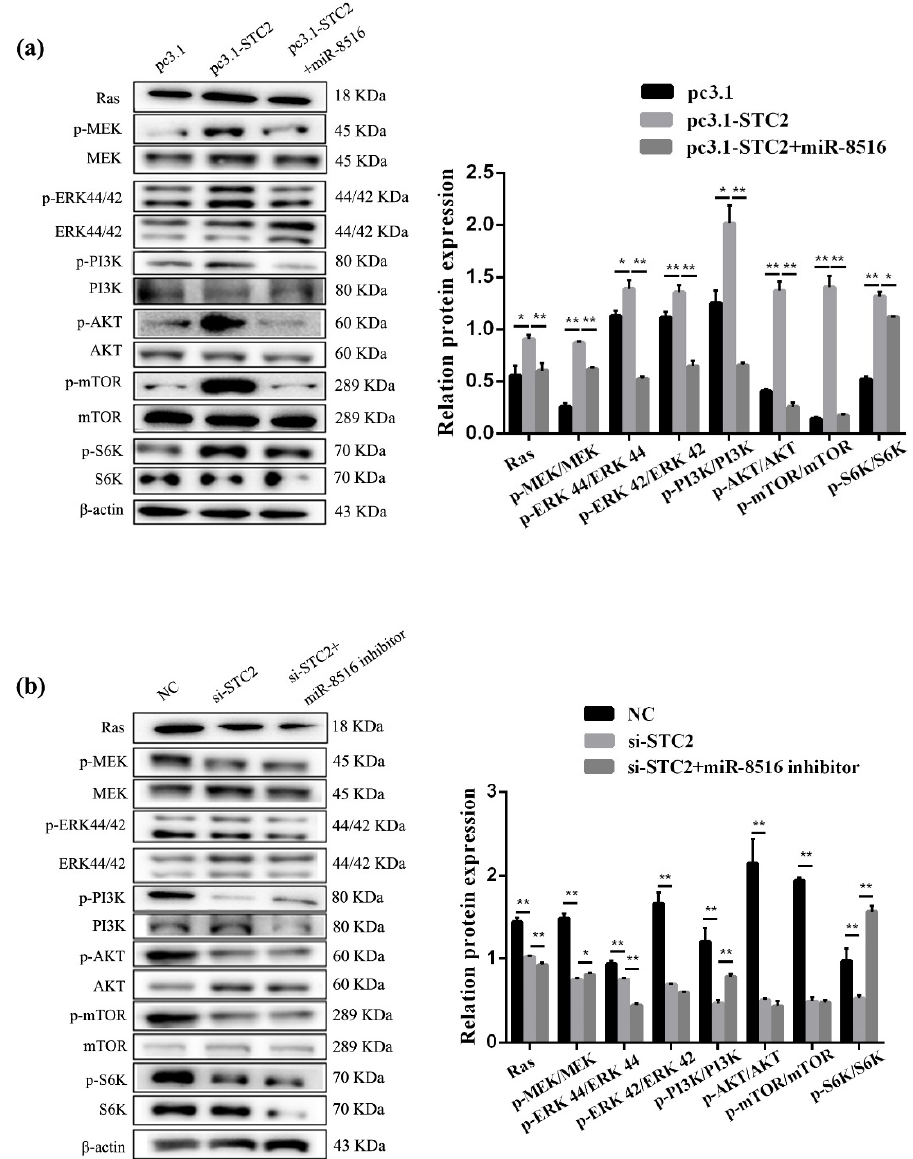
Figure 8. STC2 activated the signaling pathways of Ras / MEK / ERK and PI3K / AKT / mTOR in GMEC. ( a , b ) Western blot analysis was performed to detect the protein expression of Ras, p-MEK, MEK, p-ERK44 / 42, ERK44 / 42, p-PI3K, PI3K, p-AKT, AKT, p-mTOR, mTOR, p-S6K, S6K and β -actin in GMEC after transfection with pc3.1-STC2 or si-STC2. Protein levels were measured by WB densitometry was normalised to the β -actin density from the same lane. Data were expressed as the means ± SEM. ** p < 0.01, * p < 0.05.